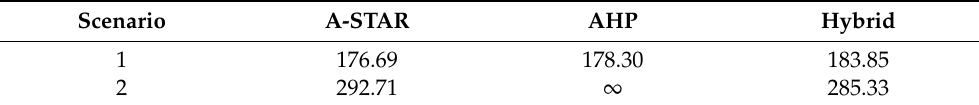
Table 2. Travel distance of path-planning